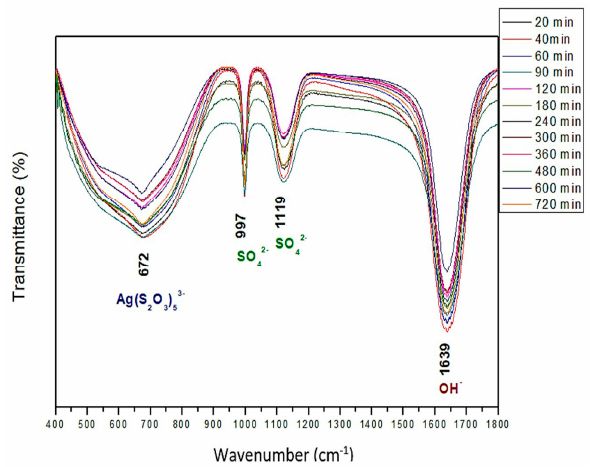
Figure 13. Spectrums of the complexed silver species obtained at several times by Fourier Transform Infrared Spectroscopy. The main vibration bands have been also indicated for purposes of identification.